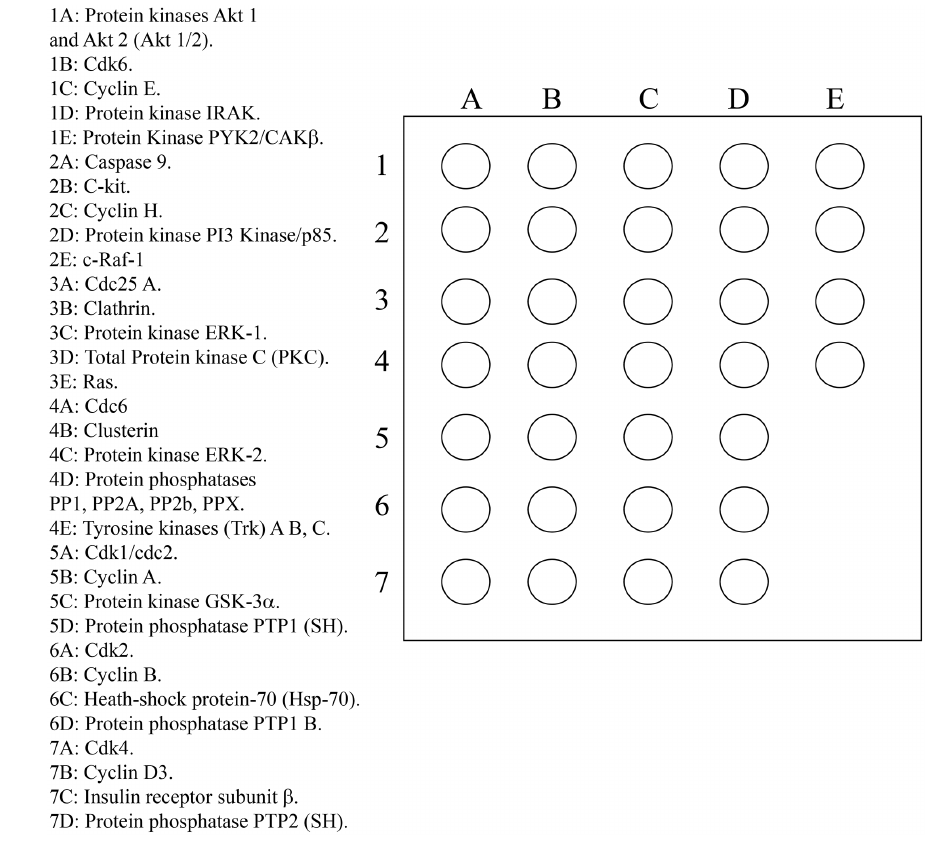
Figure 1. General scheme of protein distribution for the mini-array analysis.